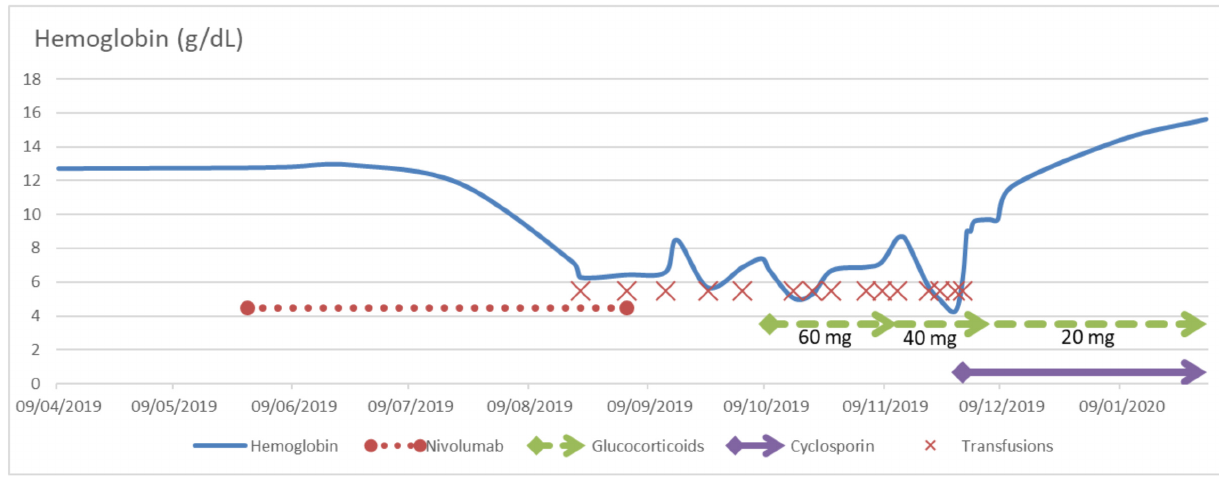
Frontiers in Oncology |